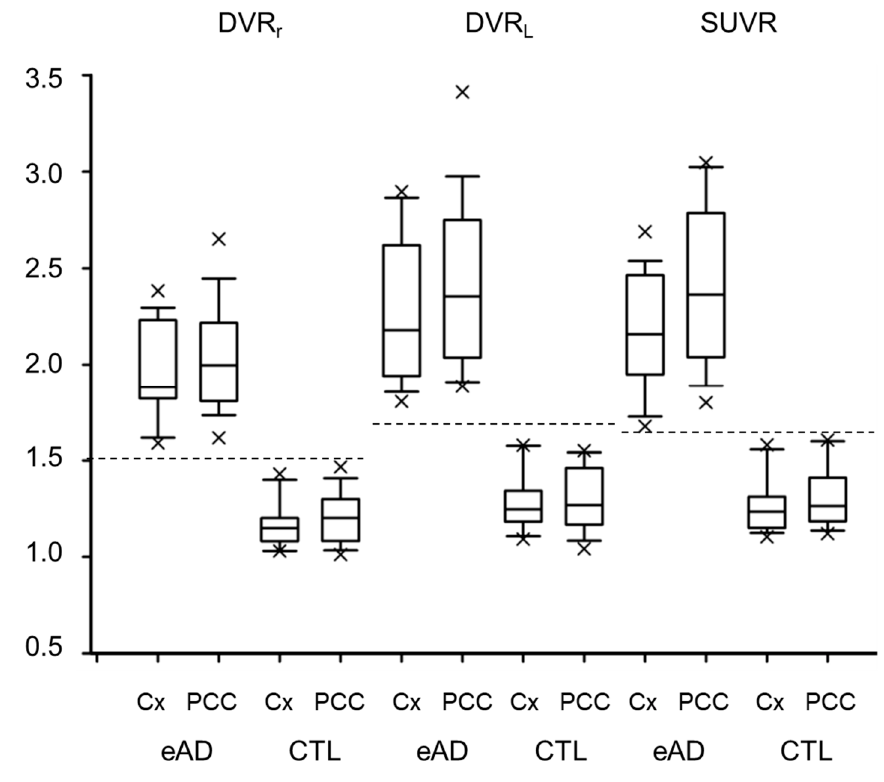
Figure 6. Cortical maximum values (Cx) of eAD and CTL obtained from each image. The posterior cingulate cortex (PCC) showed greater values than the cortical maximum among frontal, temporal, parietal, and occipital lobes. Dashed lines show optimal thresholds between eAD and CTL subjects. × is outlier of each group.